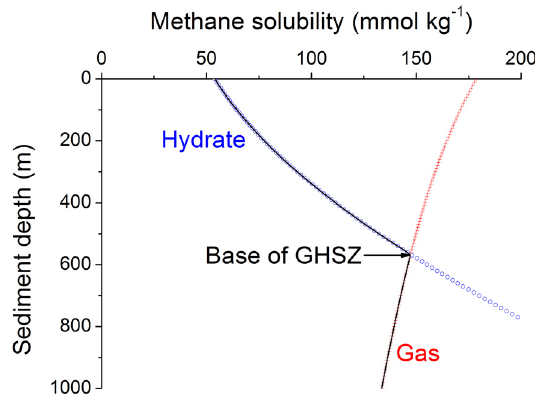
Figure 10. Solubility of methane in marine sediments deposited at 2000 m water depth. Solubility is calculated for methane hydrate (blue circles) and methane gas (red crosses) in sulfate-free seawater with S = 35 assuming hydrostatic conditions, a bottom water temperature of 2 °C and a linear geothermal gradient of 0.03 °C m − 1 [34,51]. The black line indicates the dissolved methane concentration attained in methane-saturated pore fluids (in mmol per kg solution). The base of the gas hydrate stability zone (GHSZ) is located at the intersection of the gas hydrate and free gas solubility